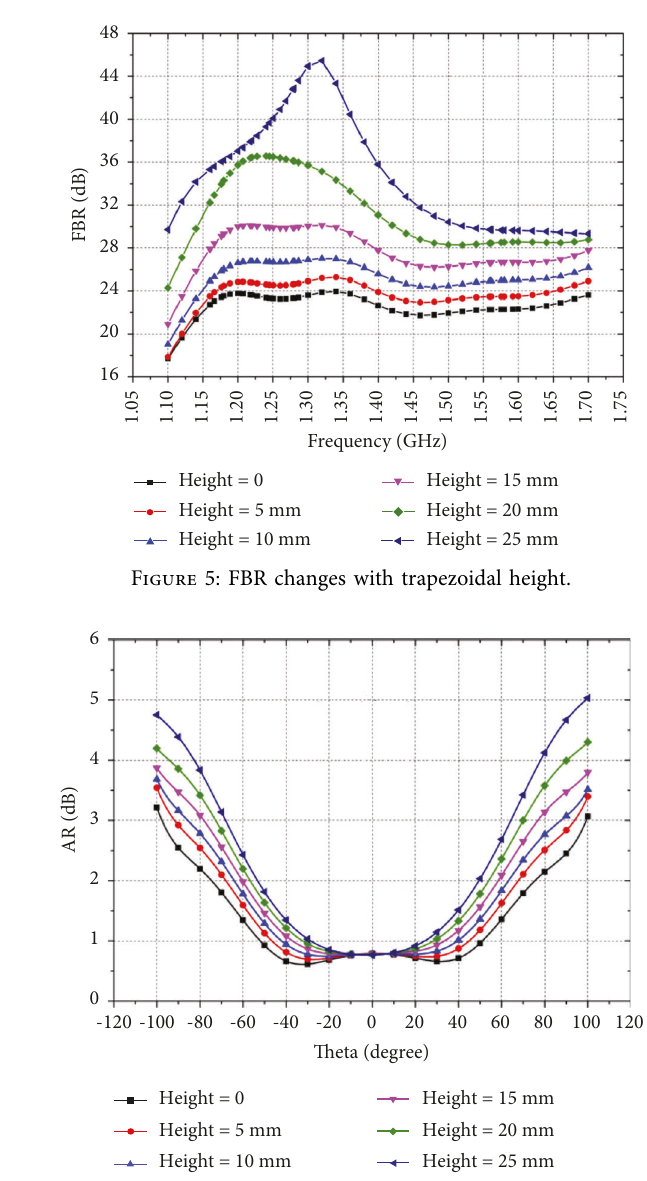
Figure 6: Change in AR with trapezoidal height.